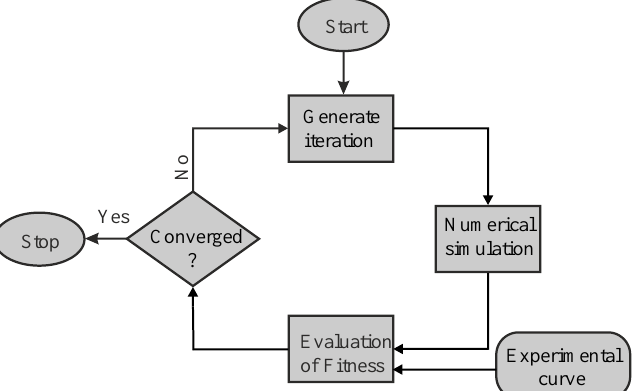
Figure 5. Optimization loop used to identify the material parameters by fitting the experimental curve with the simulation curve.